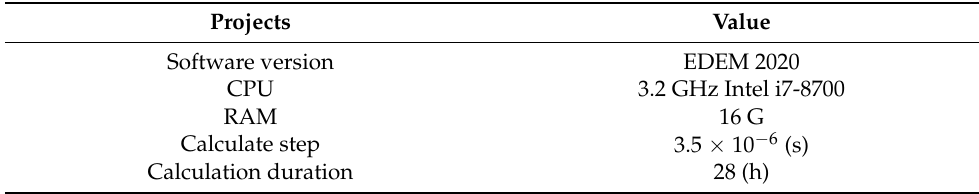
Figure 5. Initialization of oilseed rape threshing simulation. Table 4. Simulation environment.